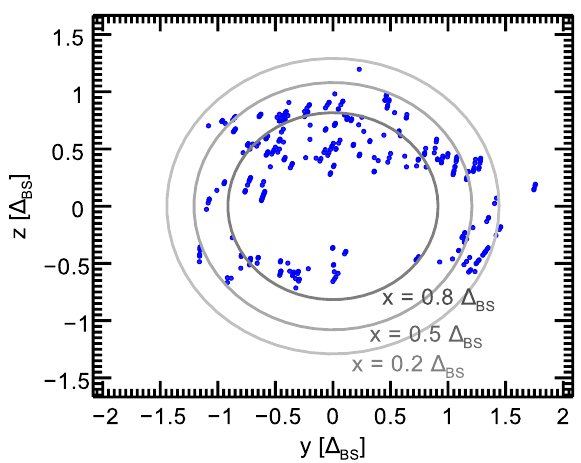
Figure 3. Location of the investigated bow shock crossings pro- jected onto the reference bow shock presented in a GSE coordi- nate system. The grey ellipsoids represent the bow shock position at x = 0 . 2 , 0 . 5, and 0 . 8 (cid:49) BS with (cid:49) BS depicting the bow shock stand- off distance.